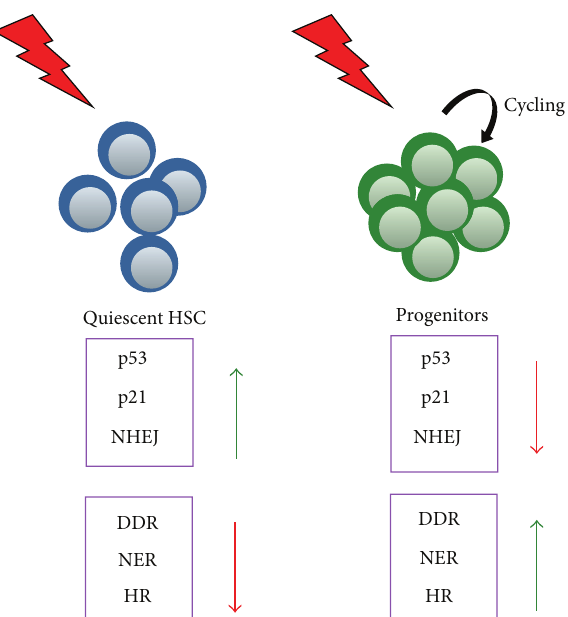
Figure 3: Quiescent HSC and proliferating progenitors respond dif- ferently to DNA damage (radiation). HSC show a higher expression level of p53 and p21 and they activate the error-prone repair pathway compared to faster cycling progenitors. They show a reduced DDR, NER, and HR response. (NHEJ: nonhomologous end joining; DDR: DNA damage response; NER: nucleotide excision repair; and HR: homologous